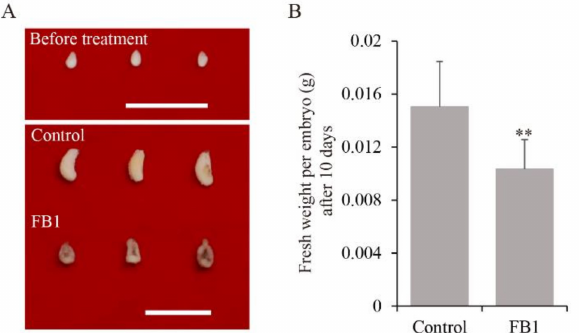
Figure 1. Sphingolipid synthesis inhibitor inhibited cotton embryo growth. ( A ) Phenotype of 2 DPA embryo before treatment and FB1 treated embryos after 10 days of in vitro culture. Scale bars = 1 cm. ( B ) Fresh weight of FB1-treated cultured embryos after 10 days. Values represent means ± SD ( n = 30). ** indicates p ≤